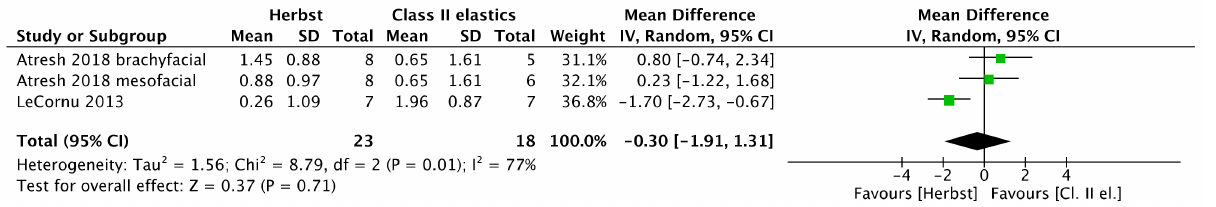
Figure 8. Forest plot of the ANS point anteroposterior changes using the random effects model [43,44].